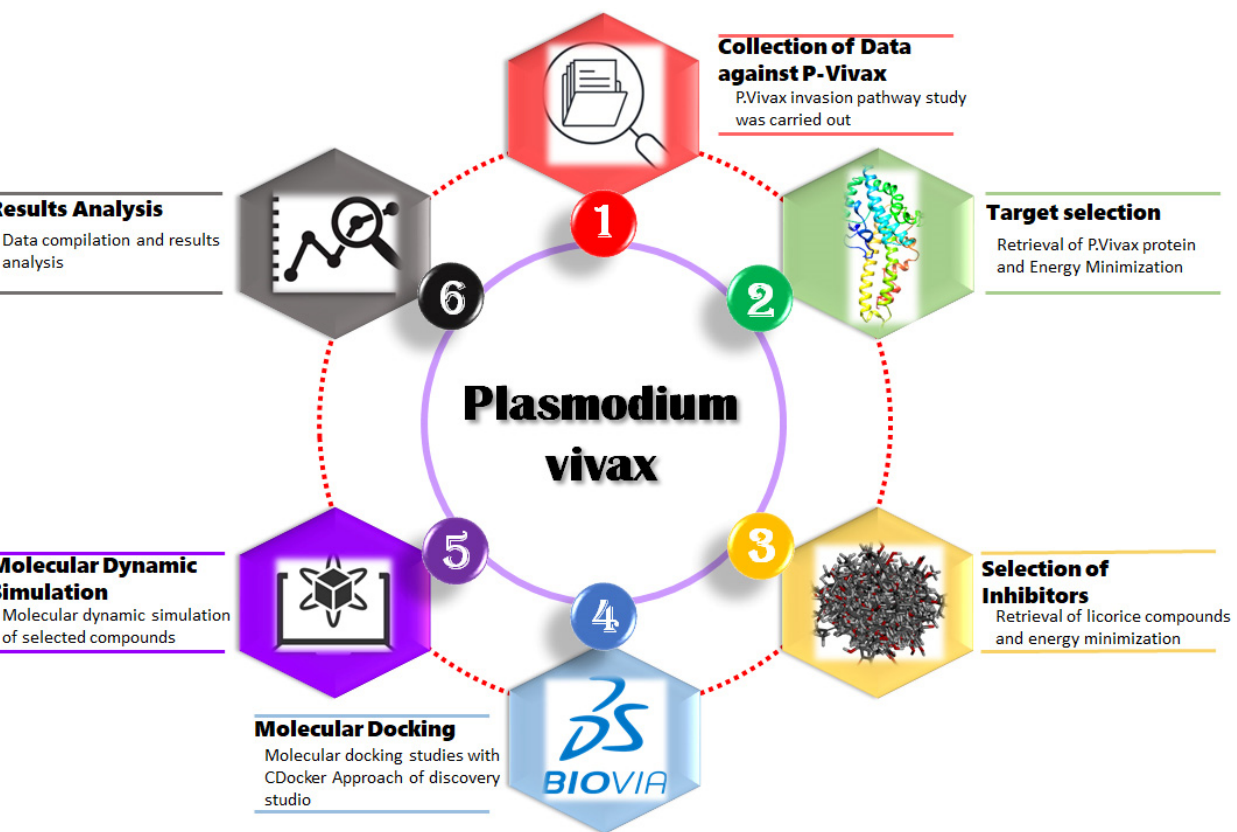
Figure 1. Workflow diagram for the screening of licorice inhibitors against DBP.